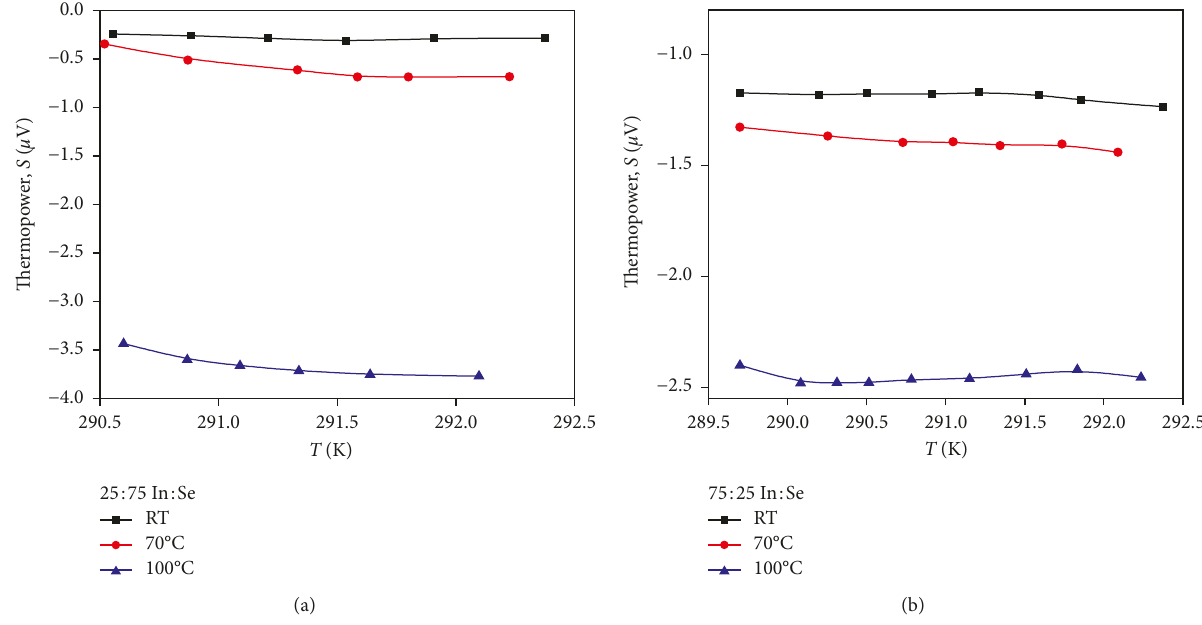
Figure 13: Graph between thermoelectric power and temperature for InSe: (a) 25:75 and (b) 75:25.